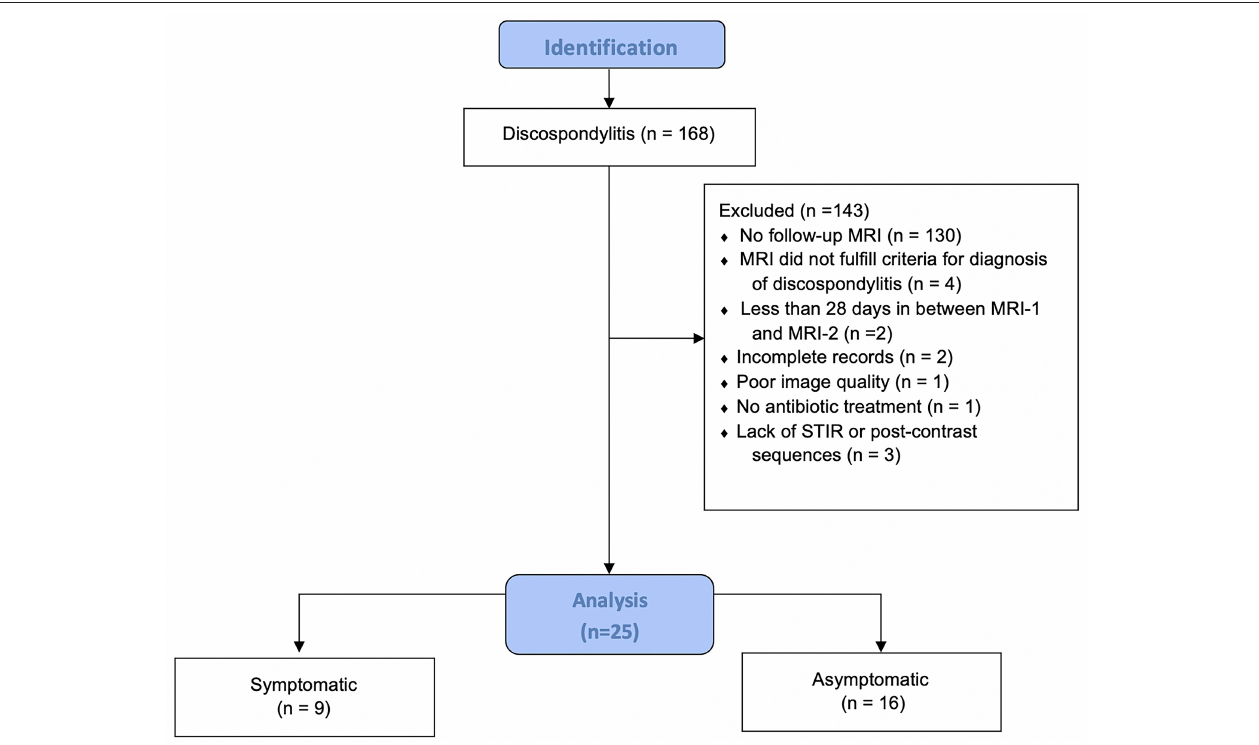
FIGURE 1 | Flow diagram illustrating the inclusion and distribution of dogs in this study. MRI, magnetic resonance imaging; MRI-2, follow-up MRI; STIR, short-tau inversion recovery; n , number of